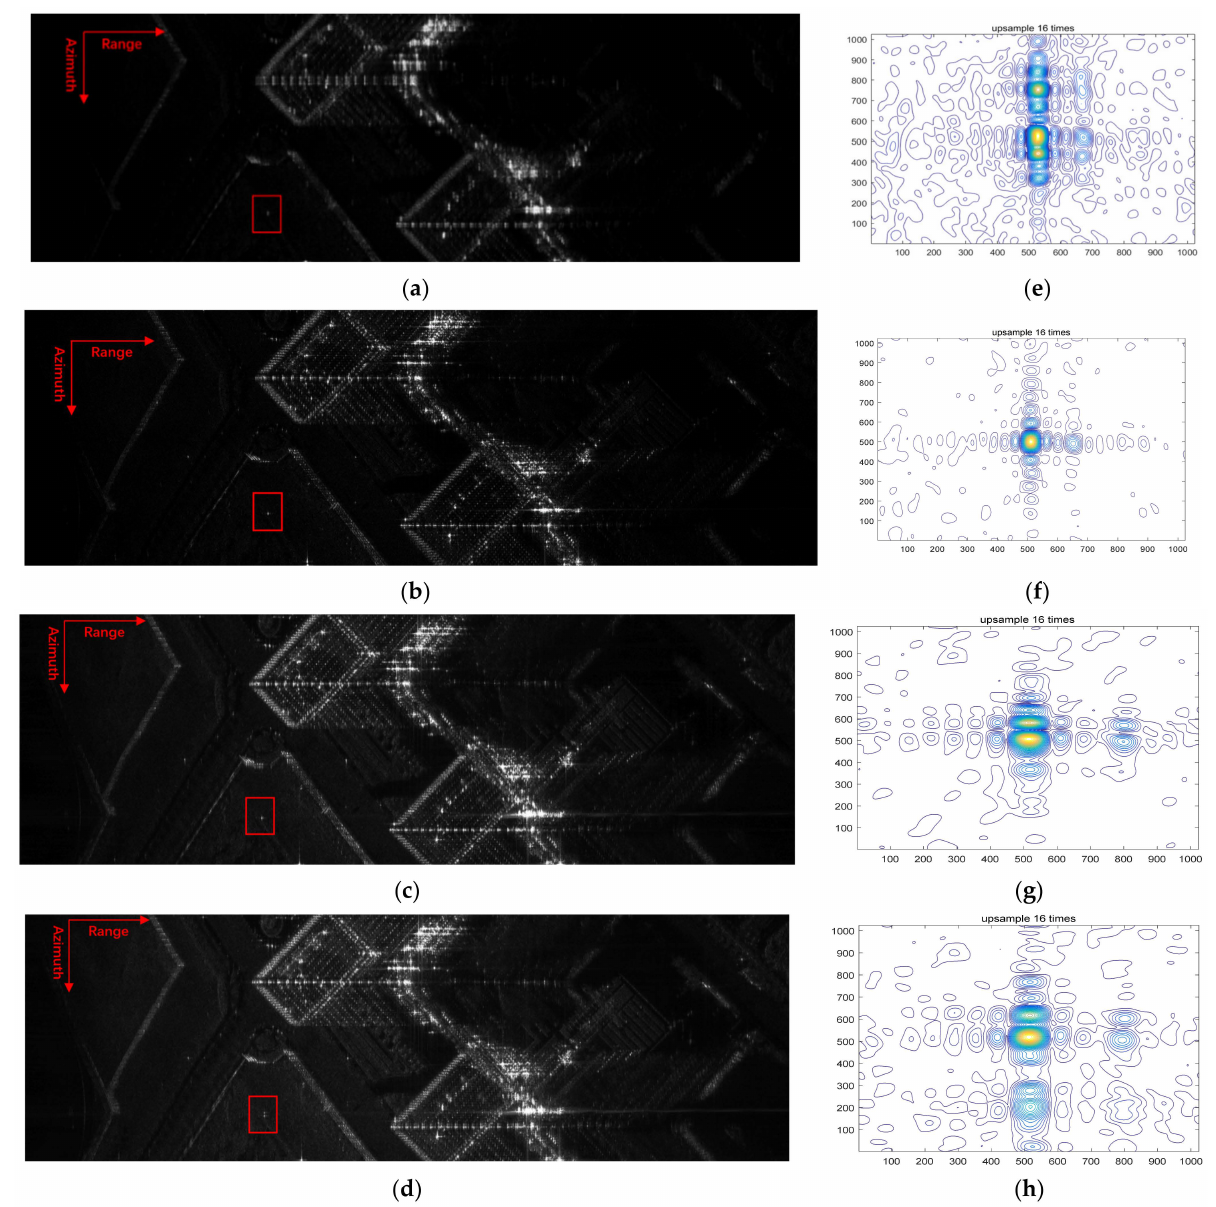
Figure 14. ( a ) Defocused image without using the estimated track for motion compensation; ( b ) Well- focused image with motion compensation when p = 1; ( c ) Focused image with motion compensation when p = 2; ( d ) Focused image with motion compensation when p = 4; ( e ) Calibration reflector of the defocused image after upsampling 16 times; ( f ) Calibration reflector of the well-focused image after upsampling 16 times when p = 1; ( g ) Calibration reflector of the focused image after upsampling 16 times when p = 2; ( h ) Calibration reflector of the focused image after upsampling 16 times when p =